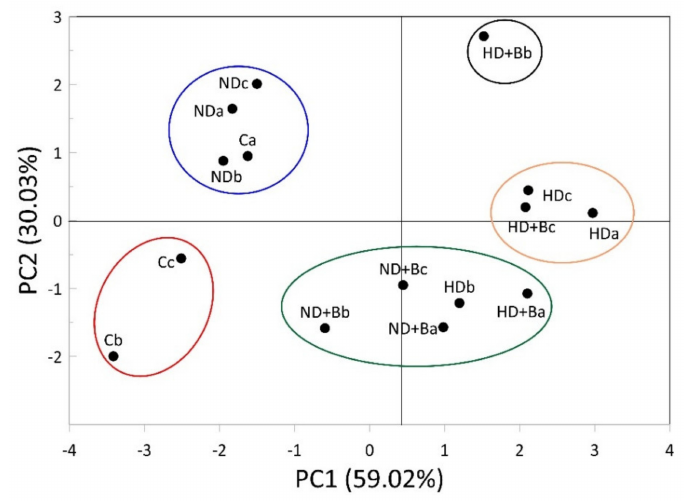
Figure 2. Hierarchical cluster analysis for the soil properties of different N fertilizer treatments with and without biochar. C—control; ND—normal dose; ND+B—normal dose with biochar; HD—high dose; HD+B—high dose with biochar; a-b-c indicate the triplicate